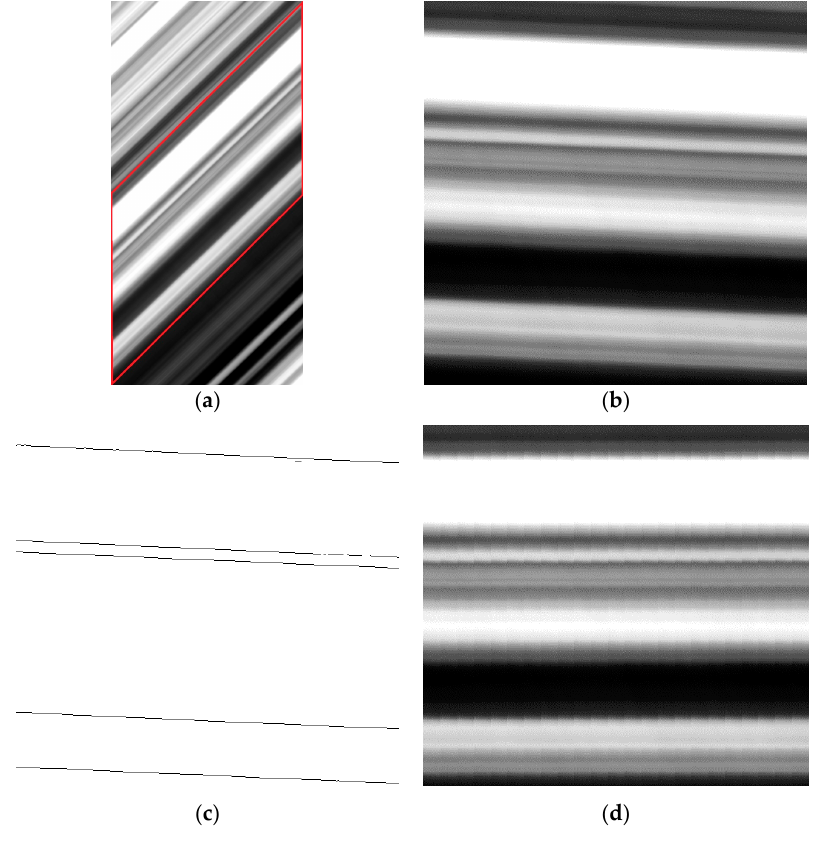
Figure 4. Results of data pre-processing. ( a ) Raw side-slither data; ( b ) Primary image corrected using Equation (4); ( c ) Results of line detection applied to the primary image; ( d ) Standard image corrected using Equation (8) with the primary image.